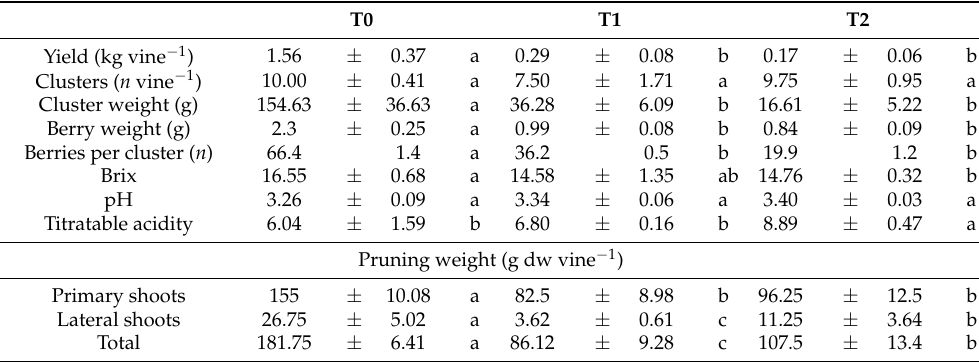
Table 2. Vine yield, number of clusters, mean cluster weight, total soluble solids ( ◦ Brix), pH, and titratable acidity (g/L tartaric acid) of fruit in the tree treatment. Each number is the mean of 4 vines ( n = 4) ± SE. Different letters indicate statistically significant means per p < 0.05 (Tukey test). T0 T1 T2 Yield (kg vine − 1 ) 1.56